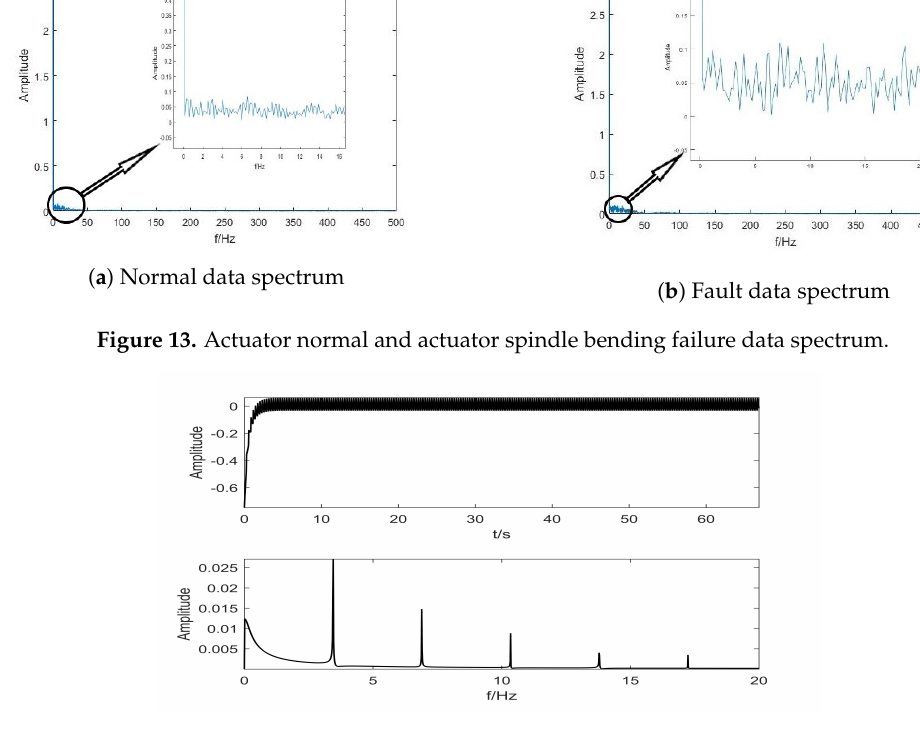
Figure 14. Tri-stable stochastic resonance output normal data spectrum.